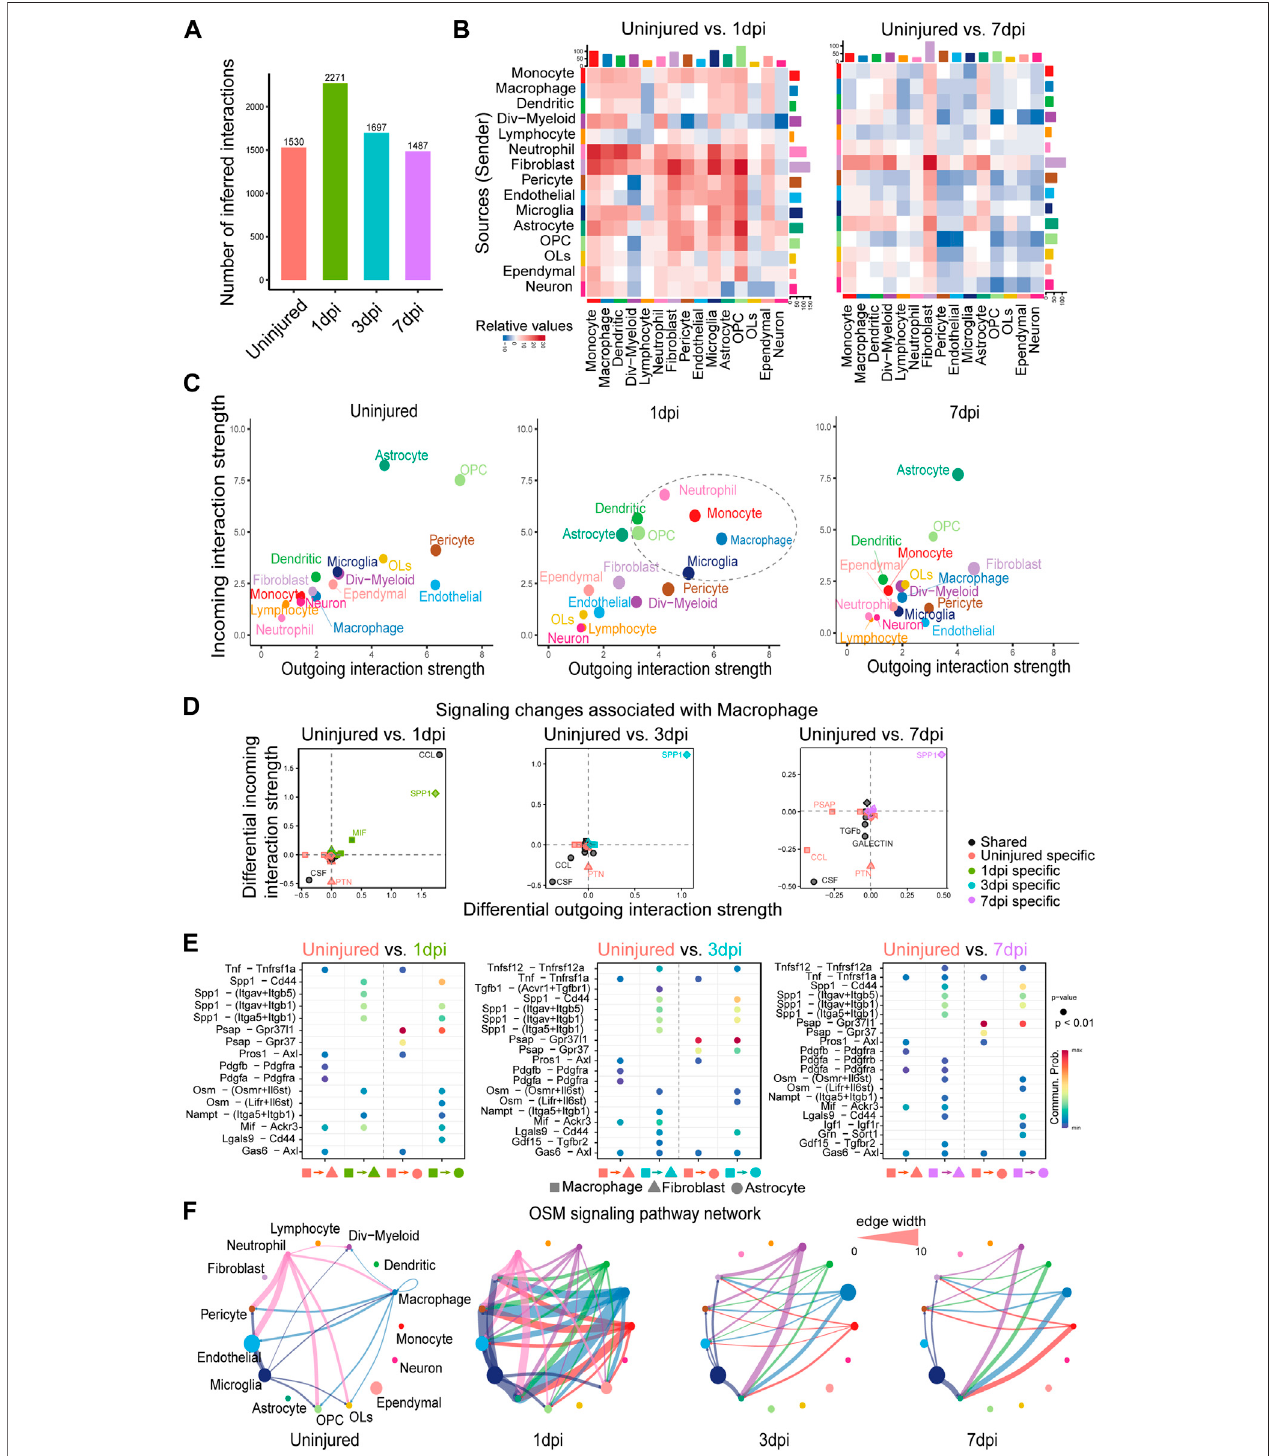
FIGURE3| Comparisonanalysisrevealsmyeloidcell – mediatedsignalingmechanismsandpinpointsthekeytimepointofsignalingchangesinresponsetomousespinalcordinjury. (A) Comparisonofthetotalnumberofinteractionsoftheinferredcell – cellcommunicationnetworksfromuninjured,1,3,and7dpi. (B) Heatmapsofthedifferentialnumberofinteractionsbetween uninjuredand1dpiaswellasuninjuredand7dpi,showingtheoutgoingandincomingsignalingchangeofeachcellgroupinagreaterdetail(Thetopcoloredbarplotrepresentsthesumofeach columnofvaluesdisplayedintheheatmap(incomingsignaling).Therightcoloredbarplotrepresentsthesumofeachrowofvalues(outgoingsignaling). (C) Scatterplotscomparingthe outgoingandincominginteractionstrengthinthe2Dspaceamonguninjured,1dpi,and7dpi. (D) Identifyingsignalingchangesassociatedwithmacrophagesbycomparinguninjuredwith1,3, and 7dpi, respectively. (E) Identi fi cation of dysfunctional signaling by comparing the communication probabilities mediated by ligand – receptor pairs from macrophages to astrocytes and fi broblasts. (F) Circle plots displaying the inferred network of the OSM signaling pathway at uninjured, 1, 3, and 7dpi. Edge width is proportional to the inferred communication probabilities.